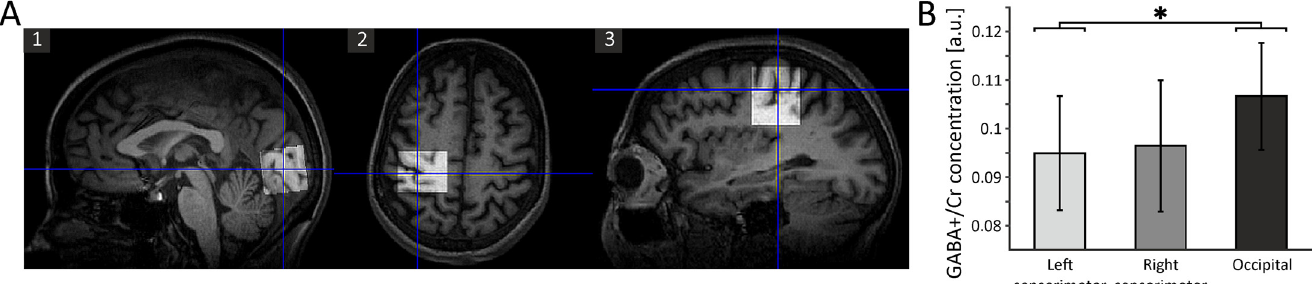
Fig 1. Localization of MRS ROIs and average GABA+/Cr concentrations across MRS ROIs. A) Placement of the occipital voxel in the sagittal plane (1), placement of the left sensorimotor voxel, centered on the hand knob, in the axial (2) and sagittal (3) planes. B) Average GABA+/Cr concentrations for the left and right sensorimotor and occipital MRS ROIs. Error bars represent standard deviations. * : p = 0.047.